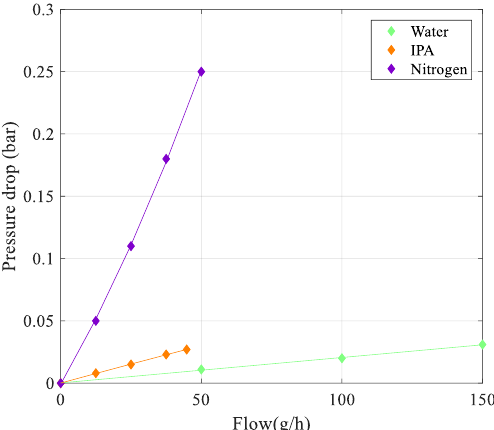
Figure 11. Measured pressure drop over the tube as a function of mass flow rate.